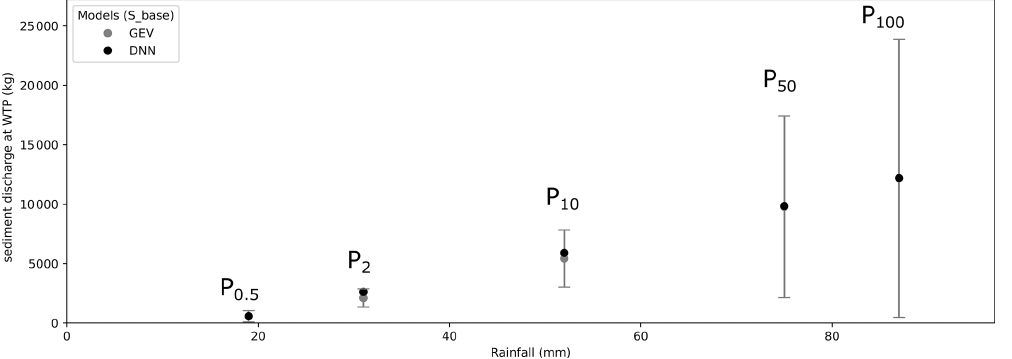
Figure 6. Simulated sediment discharge (kg) at the water treatment plant of Radicatel for the five design storms and the land use baseline scenario by (1) generalized extreme value distribution and (2) DNN modelling. The grey bars represent the 95% confidence